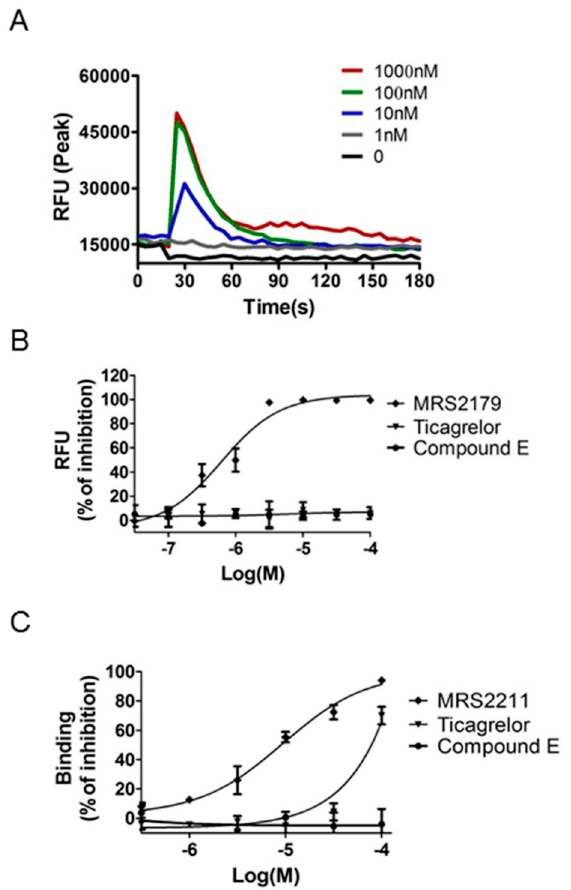
Figure 5. Selectivity for P2Y12 over P2Y1 and P2Y13 receptors (A,B) Changes in cytosolic Ca 2+ concentration in NIH3T3-rhP2Y1 + Gq cells. ( A ) Representative Ca 2+ responses triggered by serially diluted MRS2365 in NIH3T3 cells co-transfected with human P2Y1 receptor and Gq/o; ( B ) FLIPR Ca 2+ dye-loaded NIH3T3-P2Y1 + Gq cells were preincubated with indicated concentrations of MRS2179, 2-MeSAMP, ticagrelor, and Compound E (0.03–100 μ M). The inhibition of Ca 2+ increases induced by